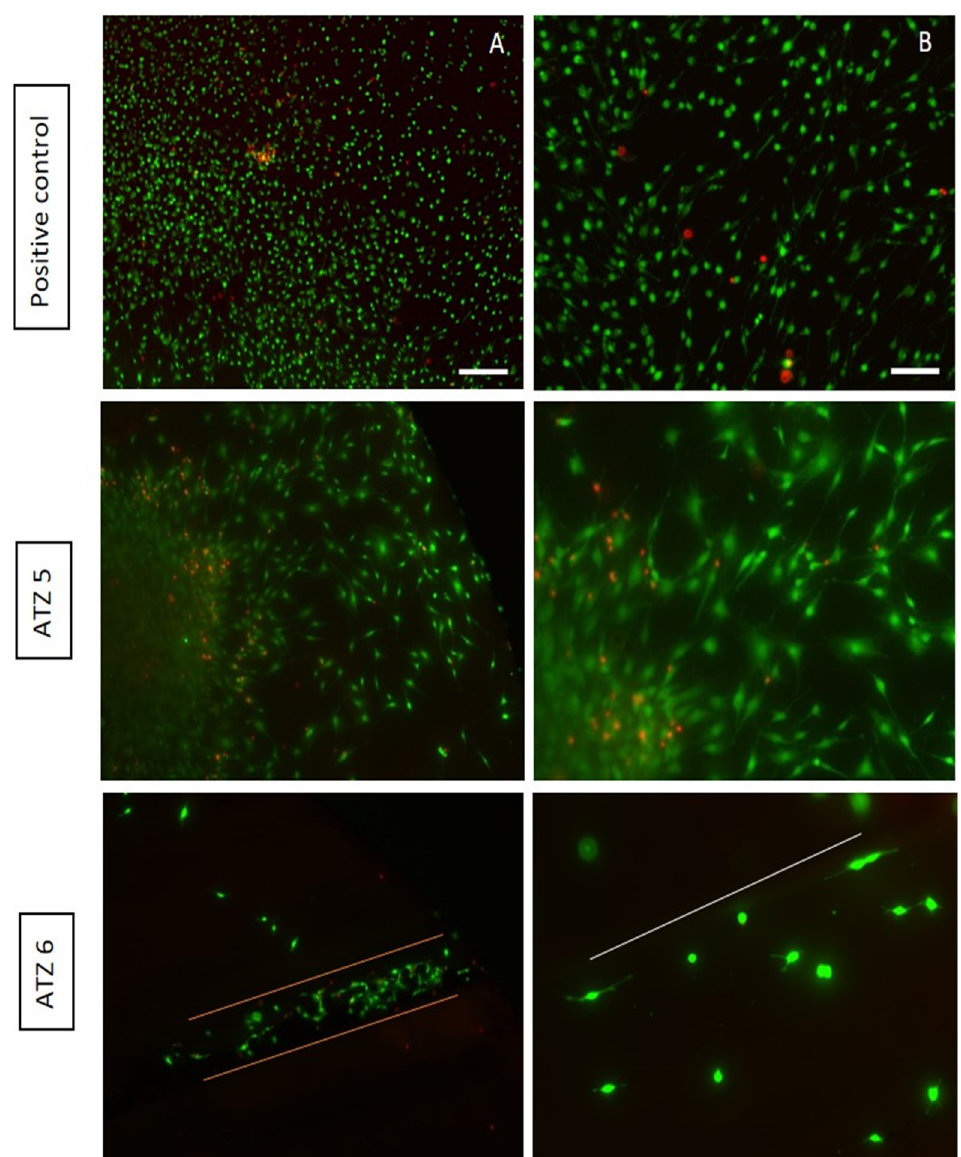
Figure 10. Fluorescence microscopy images of live/dead staining of MC3T3 mouse calvaria cells’ distribution 7 days in culture on two different alumina toughened zirconia (ATZ) ceramic laser-patterned surfaces. Living cells stain green, dead cells stain red. The white lines show the lines of the pattern on the samples. Orange lines show the edges of a groove pattern on the surface. For the positive control, staining was performed without the presence of a ceramic material. ( A ) Overview images with scale bar 200 µm. ( B ) Detailed images with scale bar 100 µm.